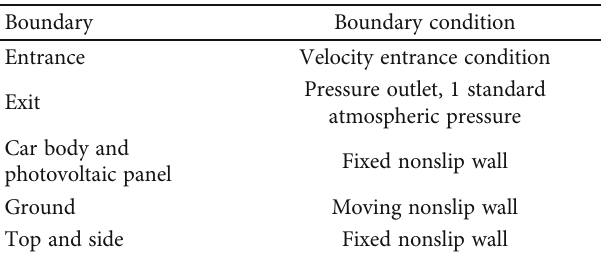
Table 2: Boundary